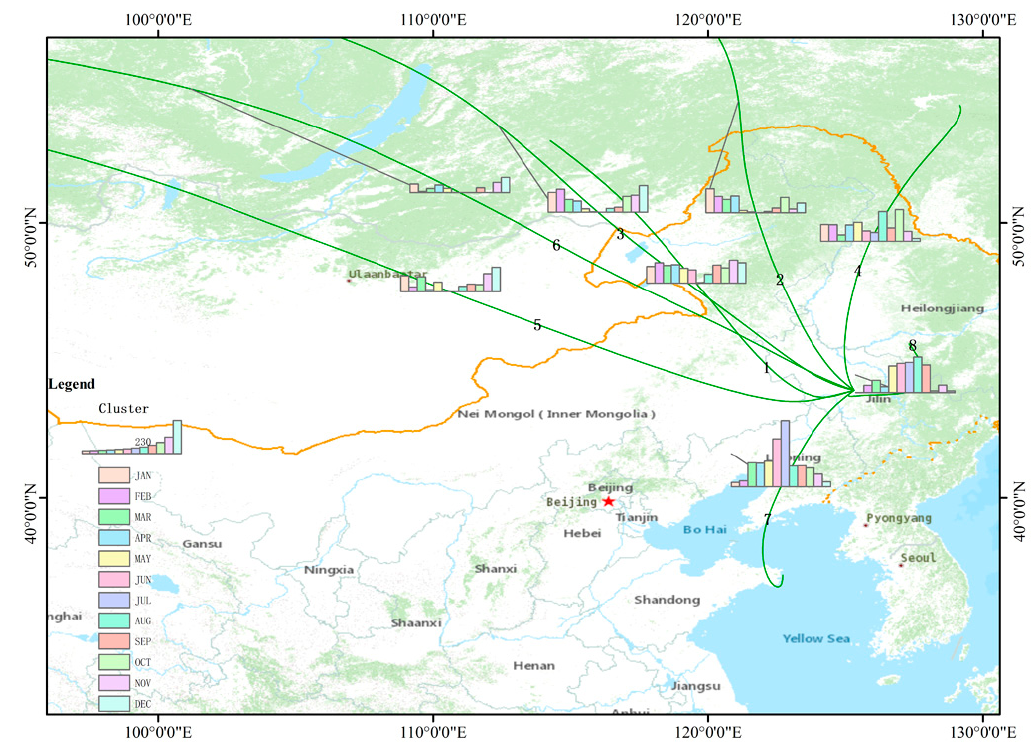
Figure 7. The average backward trajectories of Changchun City during the whole year of 2018. (the height of the columnar diagram indicates the quantity size of the average monthly trajectories).